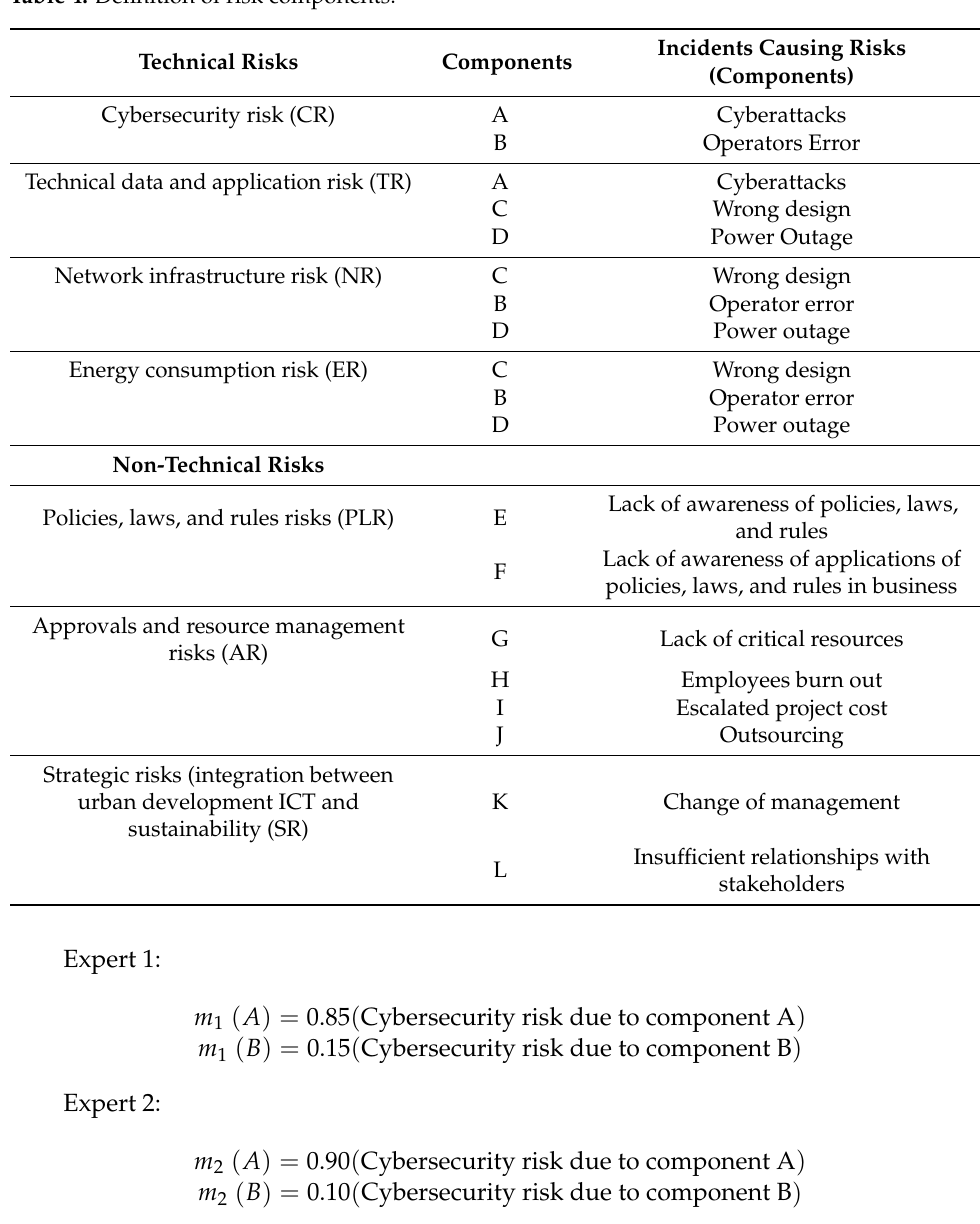
Table 4. Definition of risk